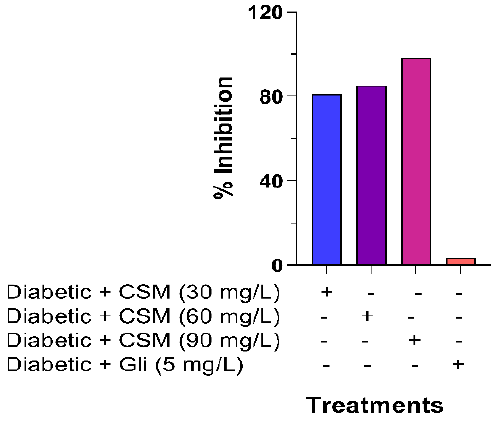
Figure 8. Effect of CSM on AGEs formation at the end of the experimental period (14 days). Values are expressed as a percentage of glycation inhibition. CSM; methanol extract from the seed of S. purpurea , Gli; glibenclamide.